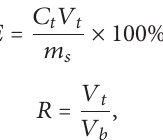
were added to 3 mL . 4